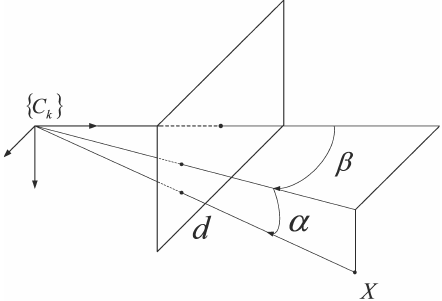
Figure 2: Landmark parameterization in inverse depth polar coor- dinates. X is the Cartesian coordinate vector associated with the inverse depth parameterization Y = [ α β ρ ] , with elevation an- gle α , azimuth β and inverse depth ρ = 1 / d , all w.r.t. the anchor system { c k }